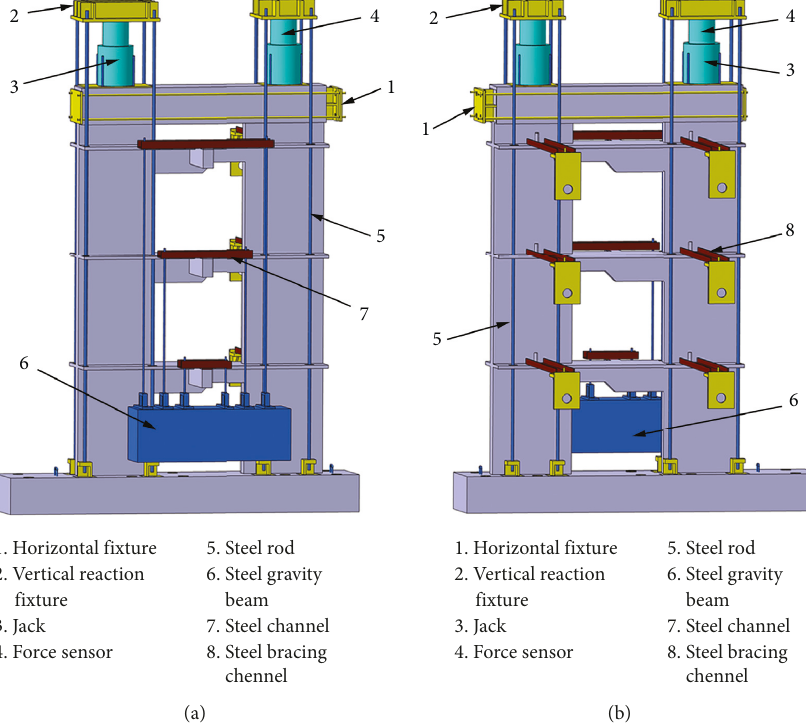
Figure 4: Illustration of the test setup. (a) Front elevation. (b) Back elevation.